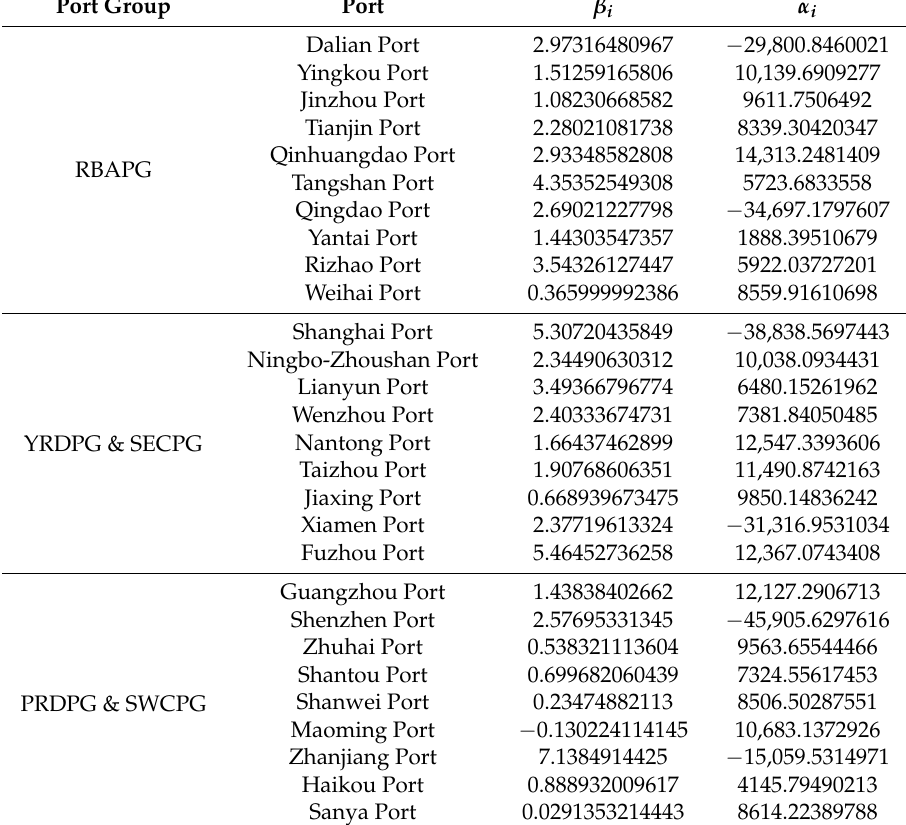
Table 4. Panel model coefficient β i and intercept α i of coastal ports at the port